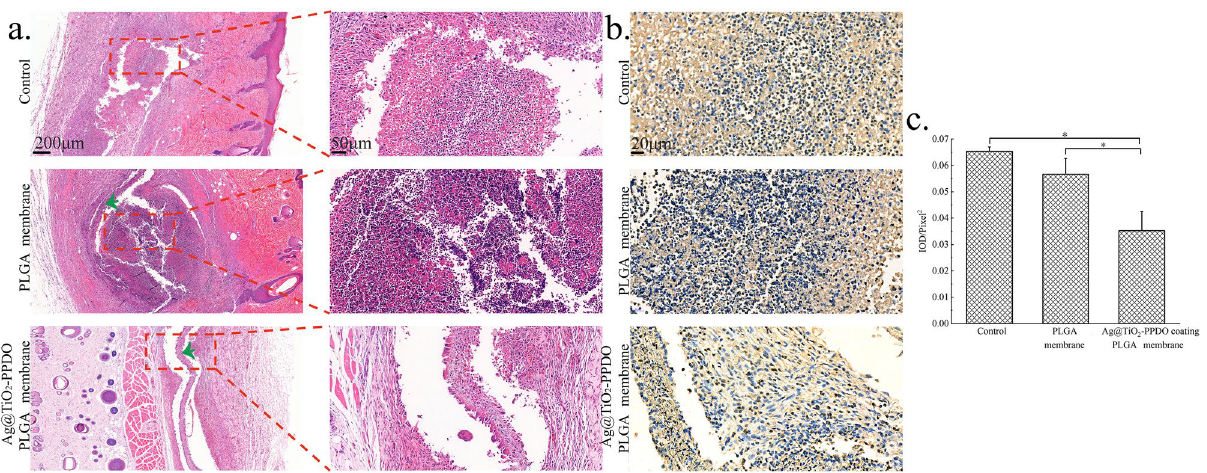
Figure 6. ( a ) H&E staining (green arrows indicate the implanted membranes); ( b ) TNF-α immumohistochemical staining of subcutaneous tissues treated with different materials; ( c ) Statistical IOD of TNF-α immumohistochemical